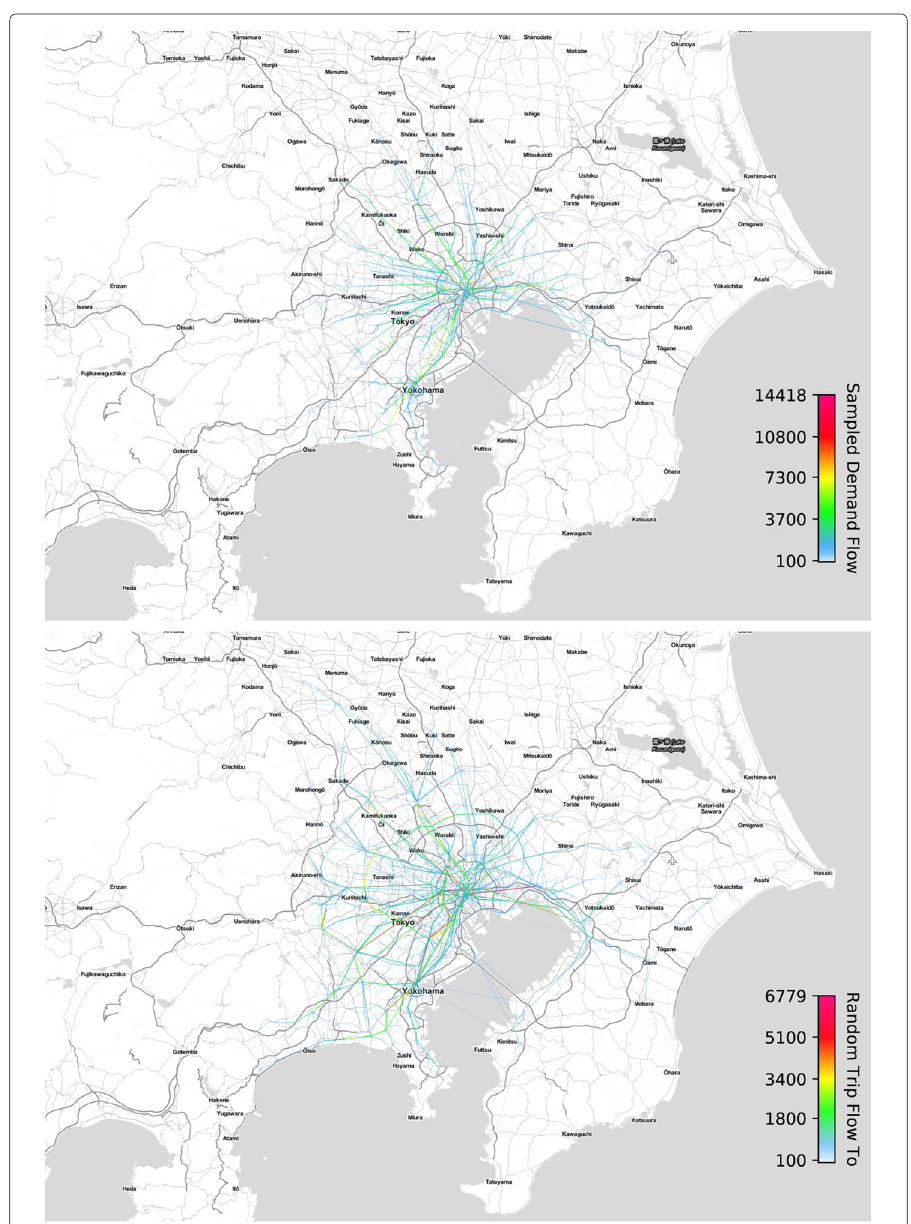
Fig. 8 A map of the Tokyo area showing the flow solution found by the simplex algorithm using a sample of one million people/jobs (top) and the edge-use frequency among 300,000 generated trips to-work (bottom – reverse trip map available in the Additional file 1). To focus attention on the heavily used corridors, we filtered edges with fewer than 100 trips in these diagrams (but not in our analysis). Note that edges going in each direction for each pair of nodes overlap, and even at 0.3 opacity some of the difference in color may be due to the z-order. Map tiles by Stamen Design (2019), map data by OpenStreetMap(OpenStreetMap Contributors